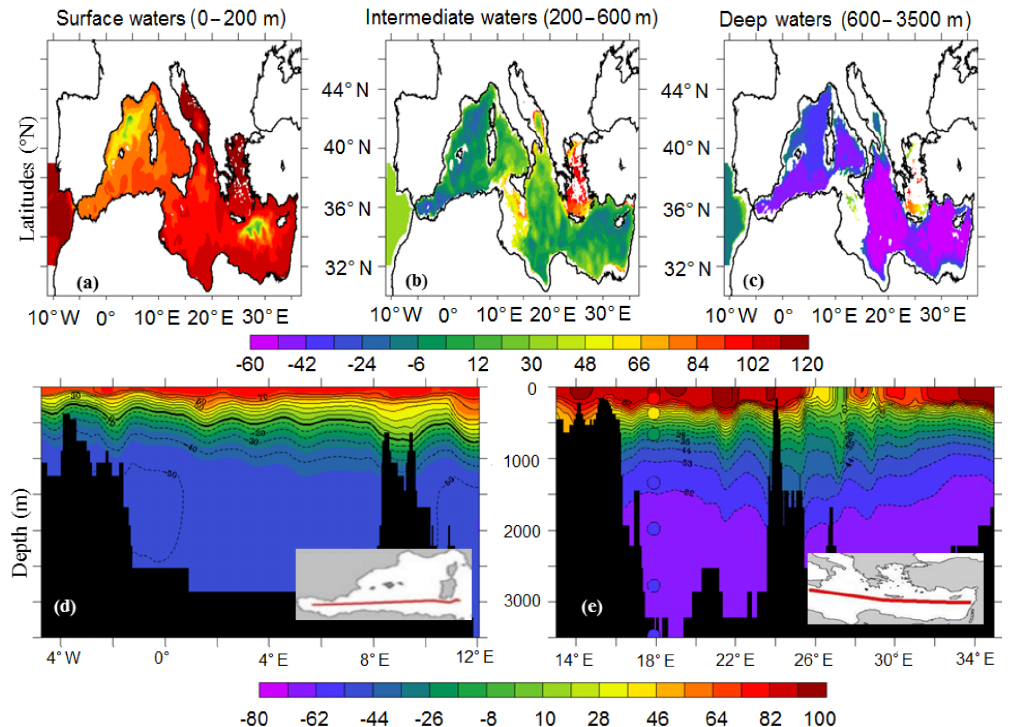
Figure 5. Model output for March 1977 for the post-bomb situation. Upper panel: mean (cid:49) 14 C (in‰) in surface waters (0 to 200m), intermediate waters (200 to 600m), and deep waters (600 to 3500m). Lower panel: (cid:49) 14 C along E–W section in (d) WMed and (e) EMed, where colour-filled dots represent in situ observations (Stuiver et al., 1983). Both model and data are reported with the same colour